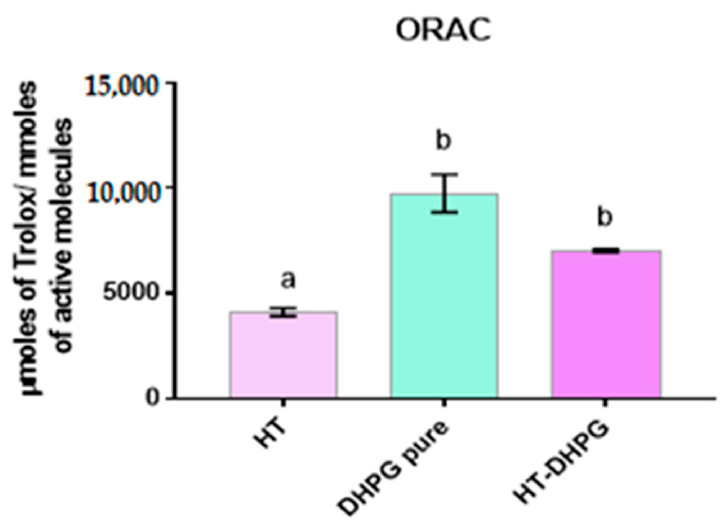
Figure 4. µmoles of Trolox equivalents obtained in each extract per mmoles of active molecule. Different letters indicate that there are significant differences between the results of the different extracts ( p < 0.05).